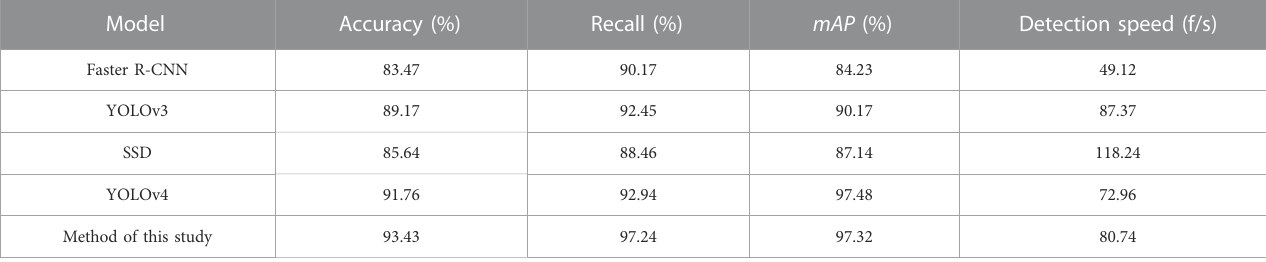
TABLE 6 Performance comparison of fi ve